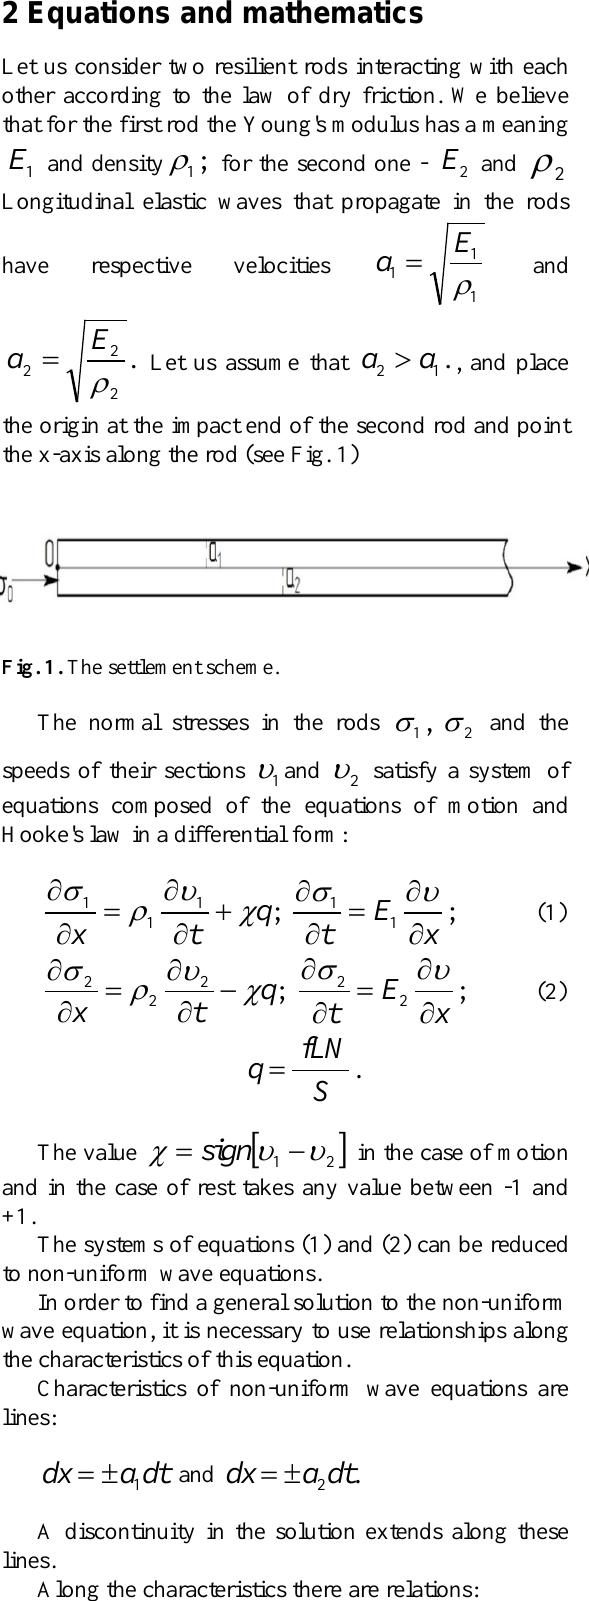
Fig. 2. The area of motion from rest